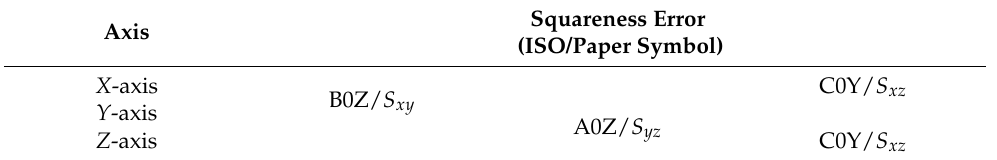
Table 4. Squareness errors for three-axis